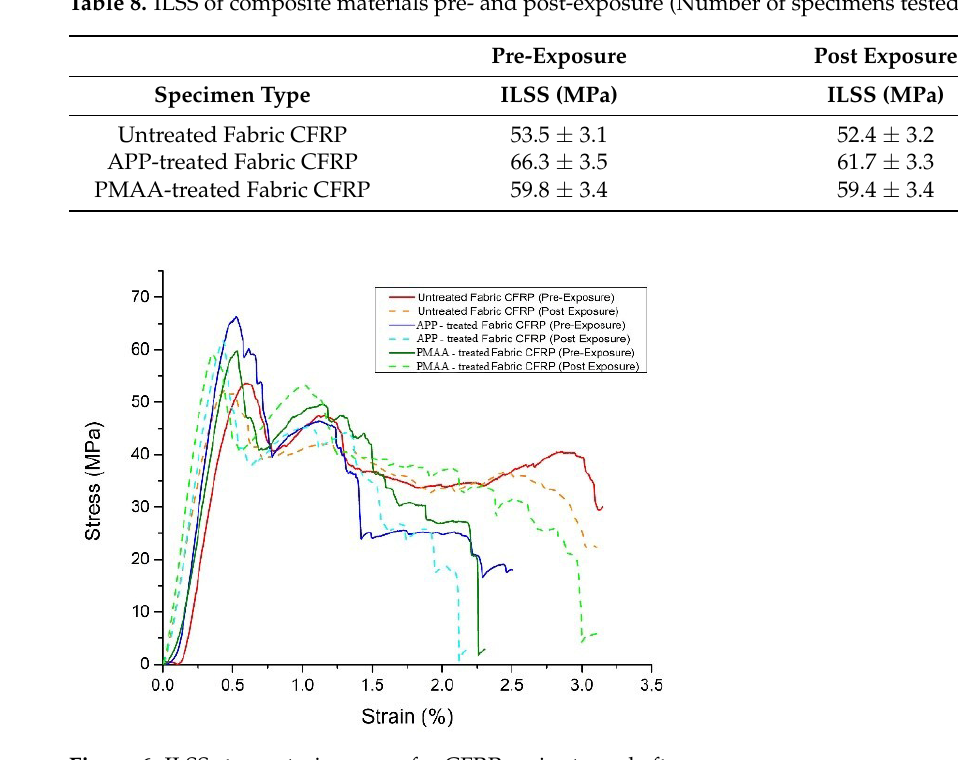
Figure 6. ILSS stress-strain curves for CFRPs prior to and after exposure.